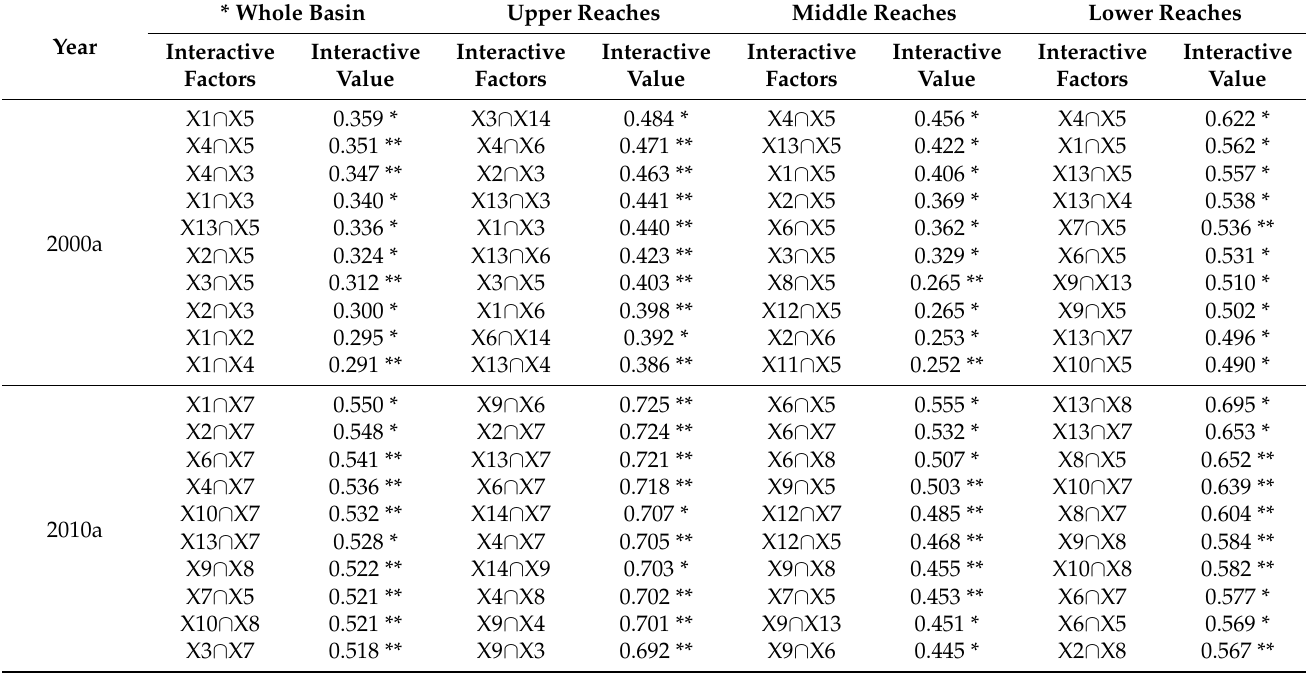
Table 7. Results of interactions among the influencing factors from 2000 to